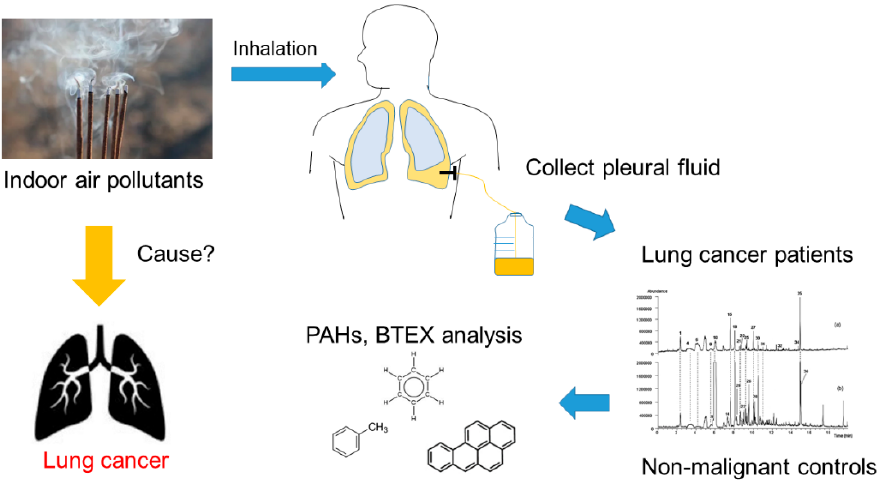
Figure 1. Research theoretical framework. The above figure shows the research hypothesis to find the cause of the rationale between indoor air pollutants and lung adenocarcinoma. PAHs: polycyclic aromatic hydrocarbons; BTEX: benzene, toluene, ethylbenzene, and